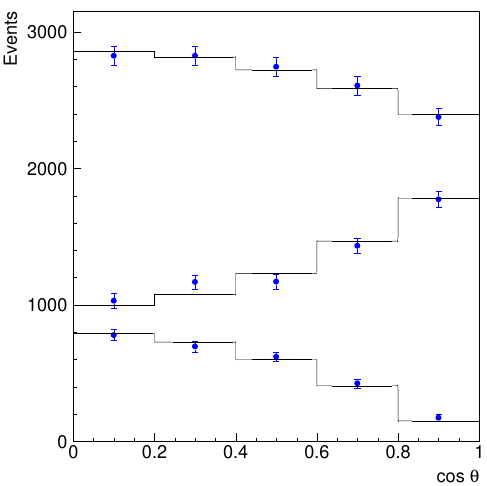
Figure 13 . The yield of B ∗ ¯ B ∗ (top set of points), B ¯ B ∗ (middle) and B ¯ B (bottom set of points) as a function of the polar angle of the B meson. The histograms show the fit